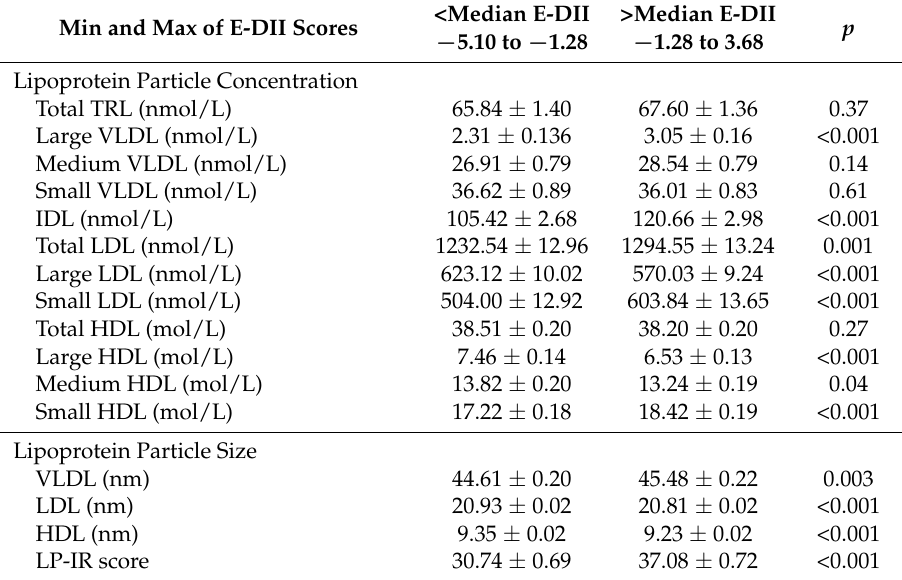
Table 3. Lipoprotein profiles of the Mitchelstown cohort ( n = 1992) according to E-DII median. Min and Max of E-DII Scores